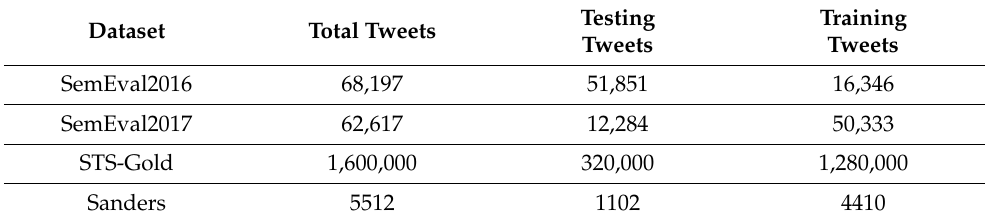
Table 4. Tweet statistics of investigated